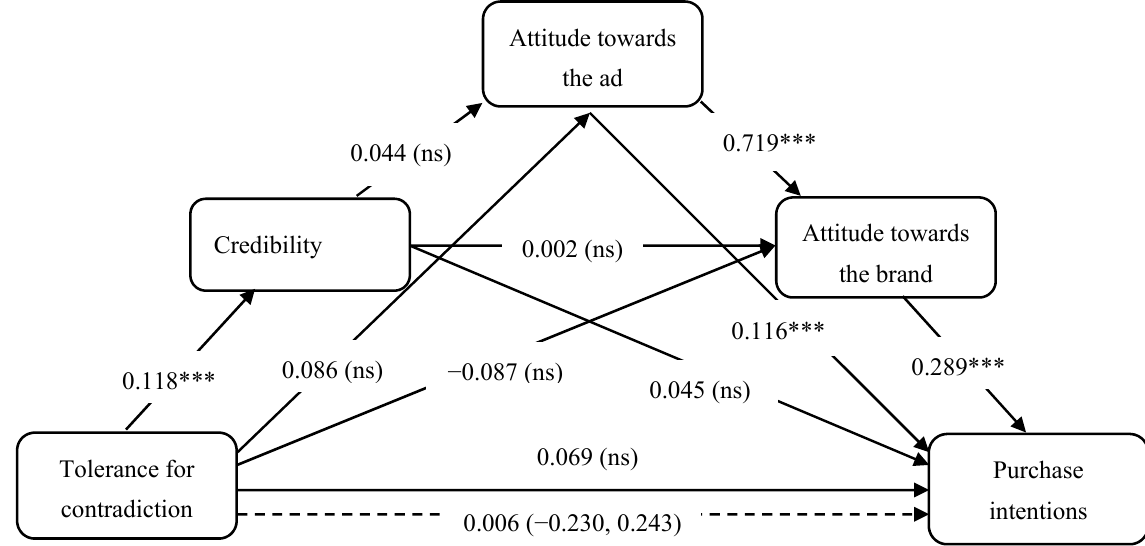
Figure 6. Conceptual model with results for Westerners. Note: *** p < 0.001.